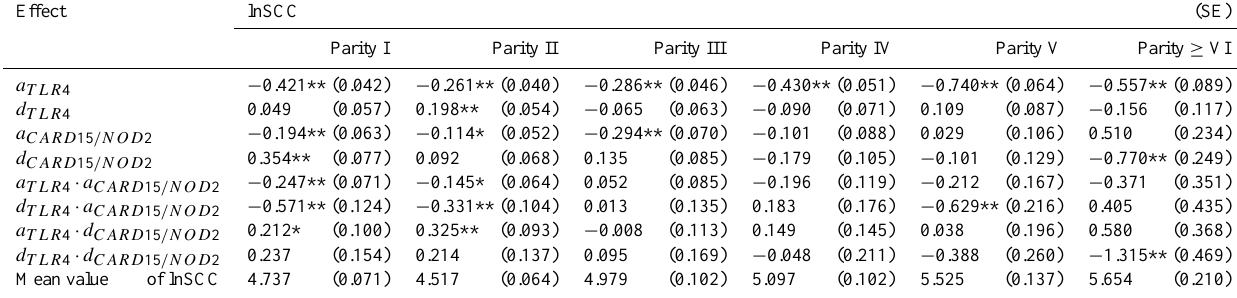
Table 4. Additive, dominance and epistatic effects of TLR4 and CARD15/NOD2 with regard to lnSCC in parities.